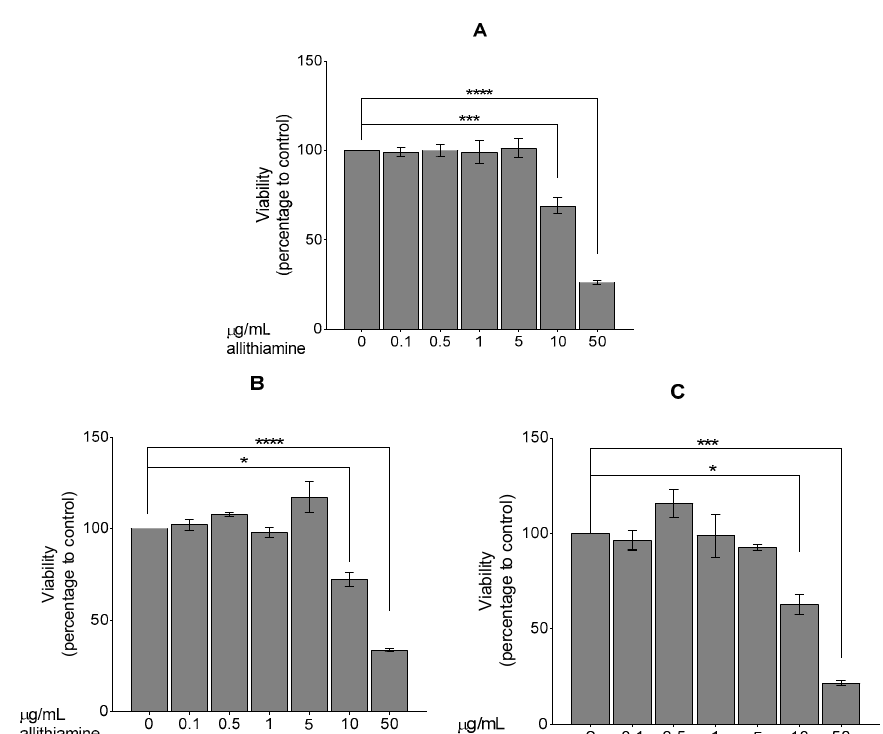
Figure 2. Viability of HUVECs was examined after 24 ( A ), 48 ( B ), or 72 ( C ) h. Results are expressed in the percentage of the control (0 µ g / mL allithiamine). Data are expressed as the mean ± SEM of three individual experiments. Two additional experiments yielded similar results. *, ***, and **** mark significant ( p < 0.05, 0.0005, and 0.0001, respectively) di ff erences compared with